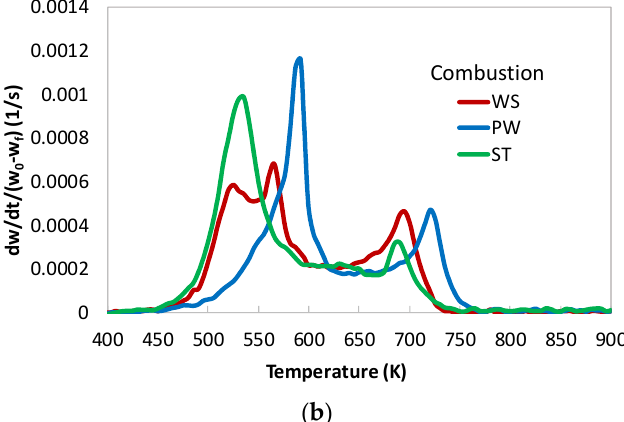
Figure 2. Derivative thermogravimetric (DTG) curves of biomasses in: ( a ) N 2 , ( b ) air.